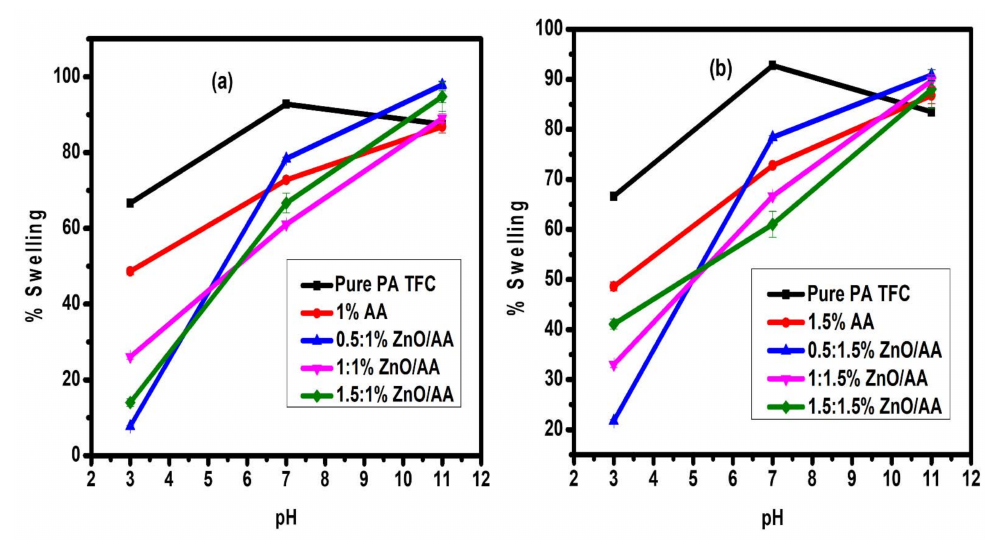
Figure 9. The percentage swelling degree analysis of: ( a ) membranes modified with 0.00% AA, 1.00% AA, 0.50:1.00% ZnO/AA, 1.00:1.00% ZnO/AA, and 1.50:1.00% ZnO/AA; and: ( b ) membranes modifies with 1.50% AA, 0.50:1.50% ZnO/AA, 1.00:1.50% ZnO/AA, and 1.50:1.50%